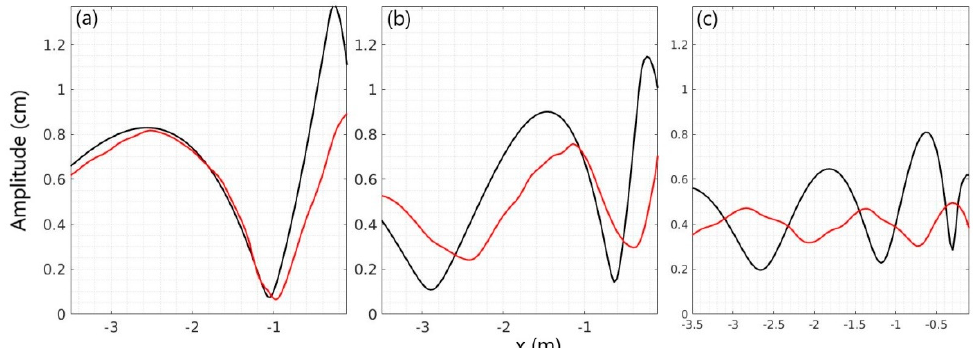
Figure 10. Cross-shore nodal pattern for long waves of different frequencies with (red) and without (black) a surf zone. Frequencies vary from f = 0.195 ( a ), 0.265 ( b ) and 0.44 ( c ) Hz.